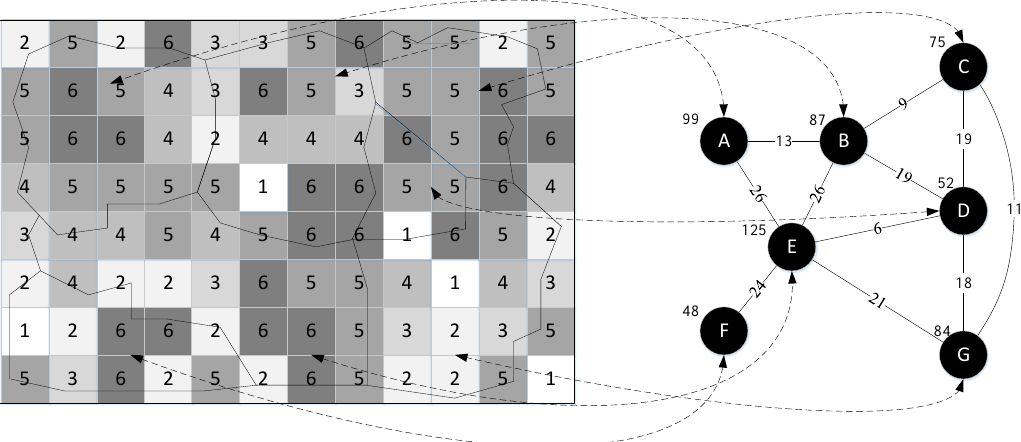
Figure 3. Graph representation of the computational loads over administrative districts (The value in each grid is the corresponding load). Table 2. Graph weight